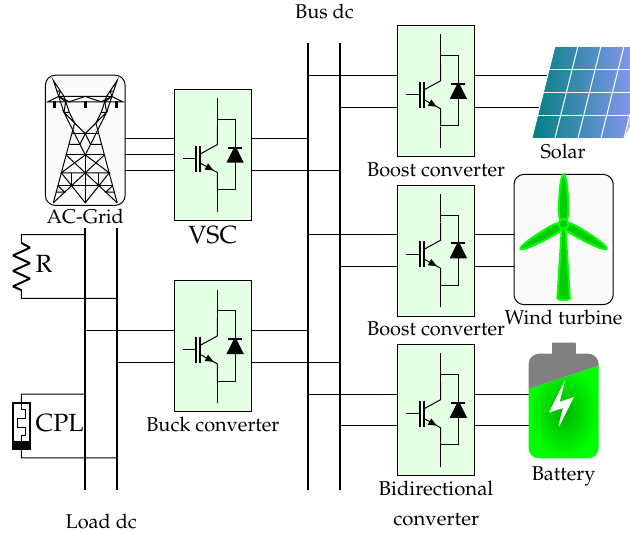
Figure 1. A typical DC microgrid with various sources and